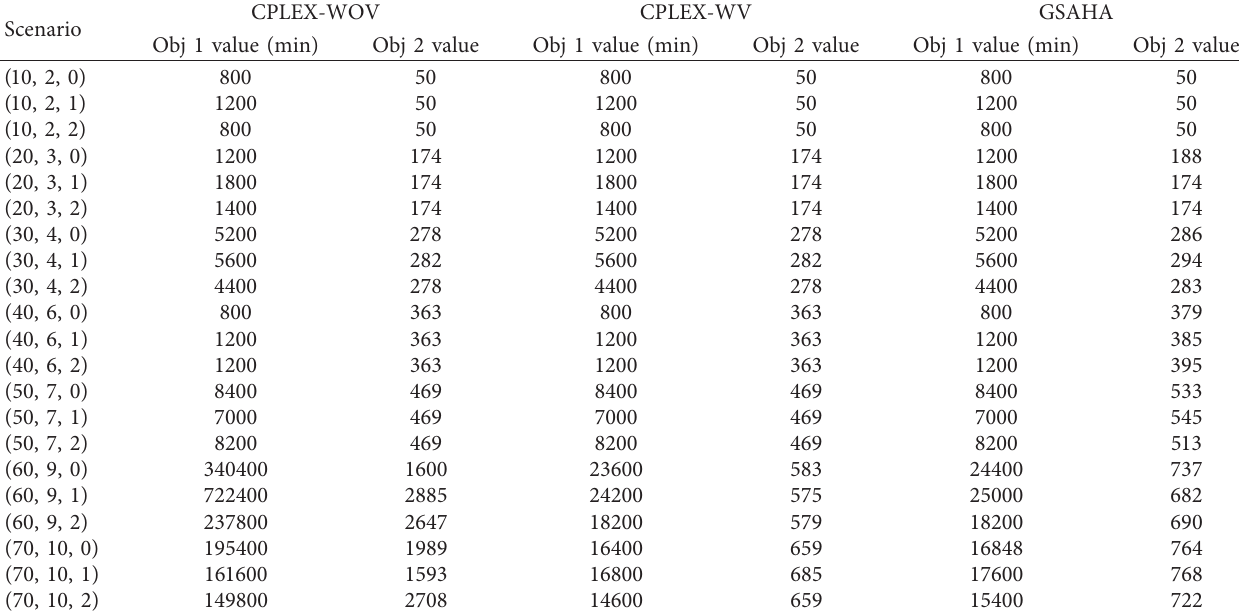
Table 8: Two components of objective values of CPLEX-WOV, CPLEX-WV, and GSAHA under different